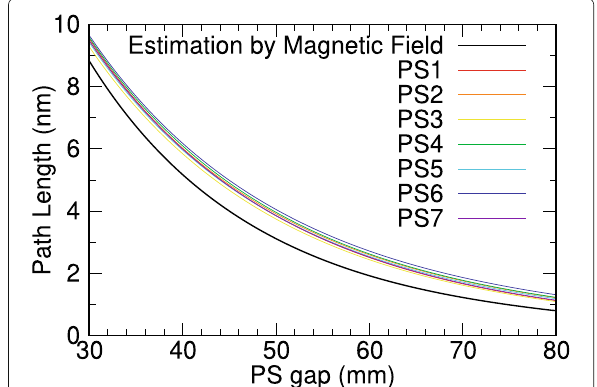
Fig. 14. As expected from the fitting results, (cid:10) h (λ) is con- stant, while (cid:10) v (λ) becomes longer at longer wavelength, which can be understood that the influence of the magnet field at the end of the vertical figure-8 ID is not negligible at the small gap.